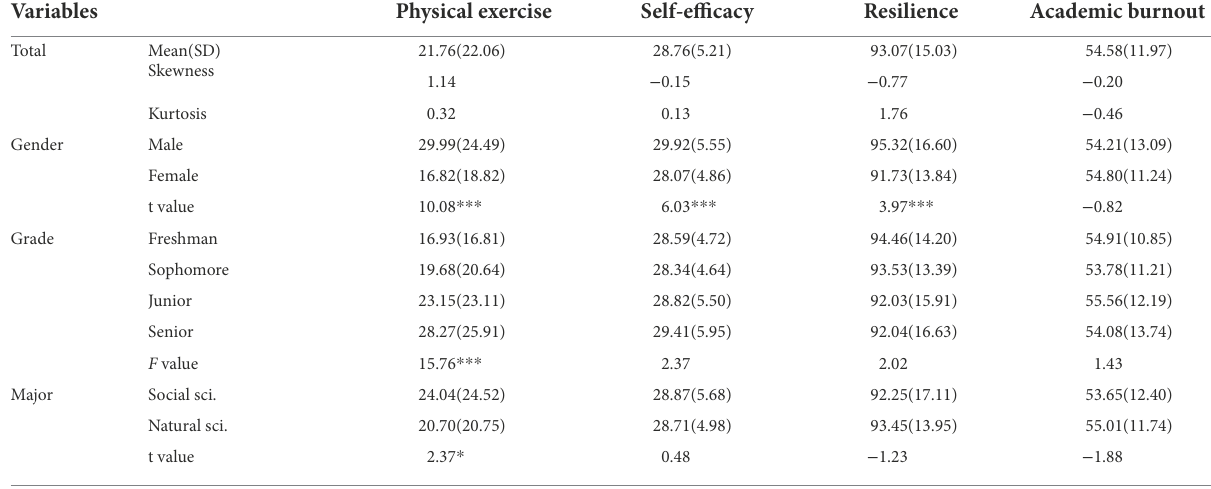
Table 1 Mean (SD) of physical exercise, self-efficacy, resilience, and academic burnout and the differences between these variables and demographic variables.